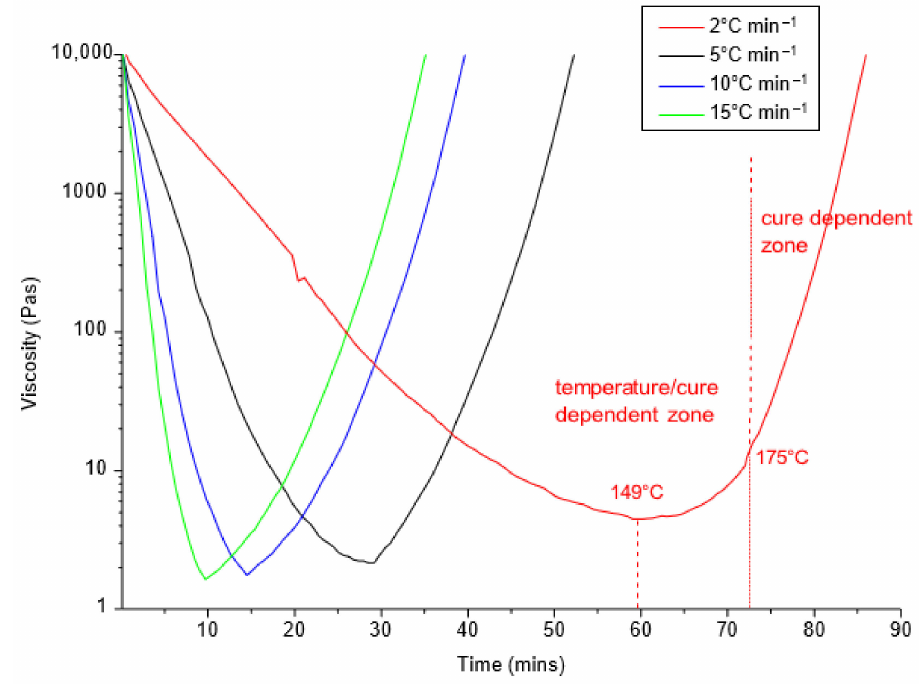
Figure 12. Resin viscosity as a function heating rates